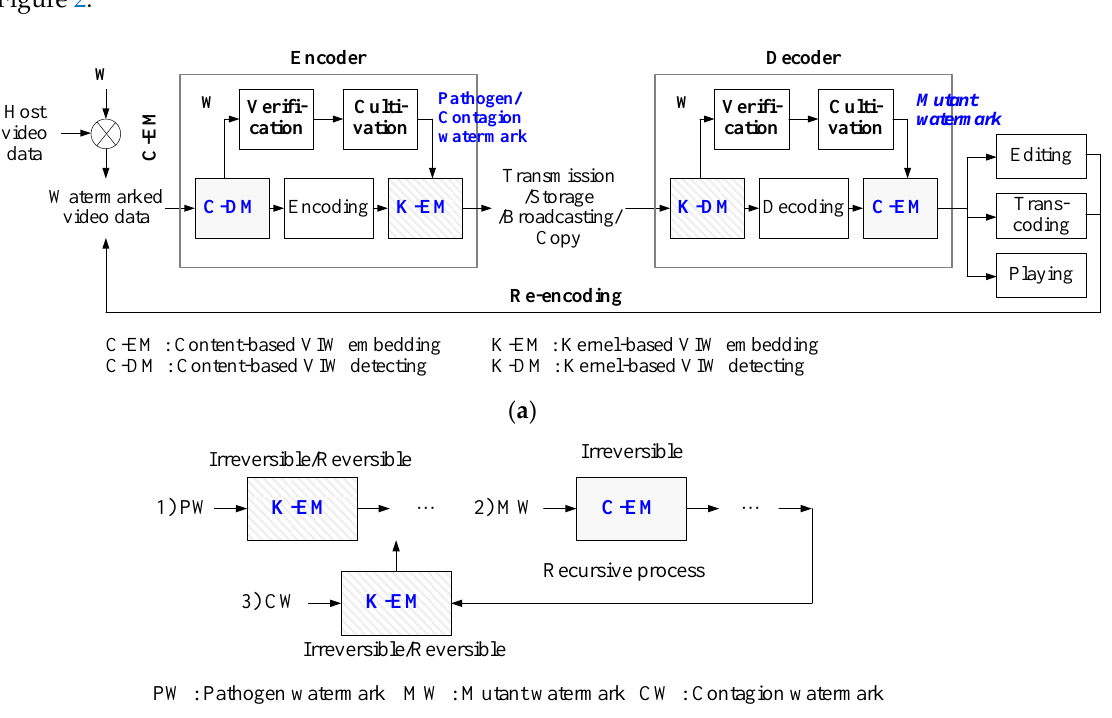
Figure 3. ( a ) Scenario for video watermarking in proposed VIW model and ( b ) infecting process for three watermarks. three